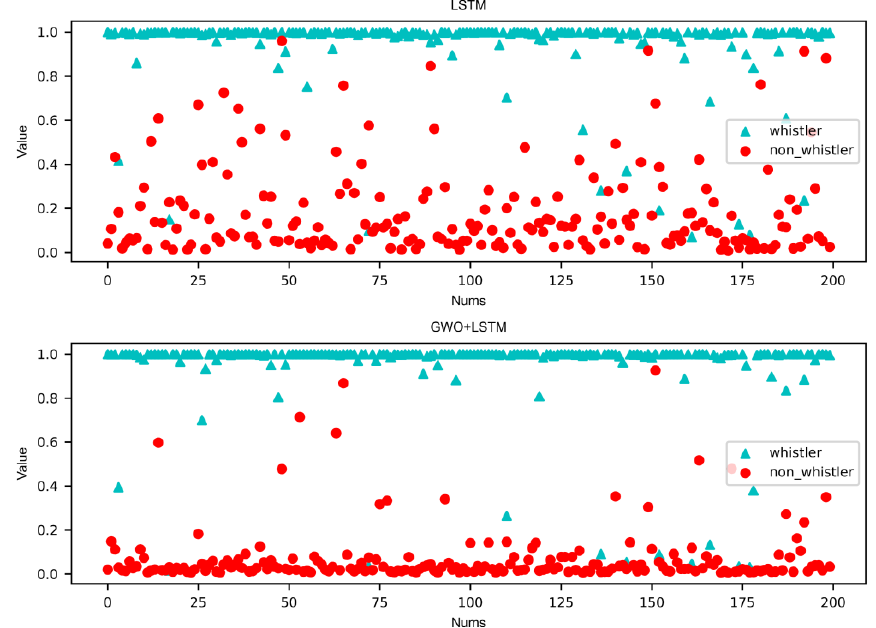
Figure 7. The output value of ℎ 𝑡 at the fully connected layer.